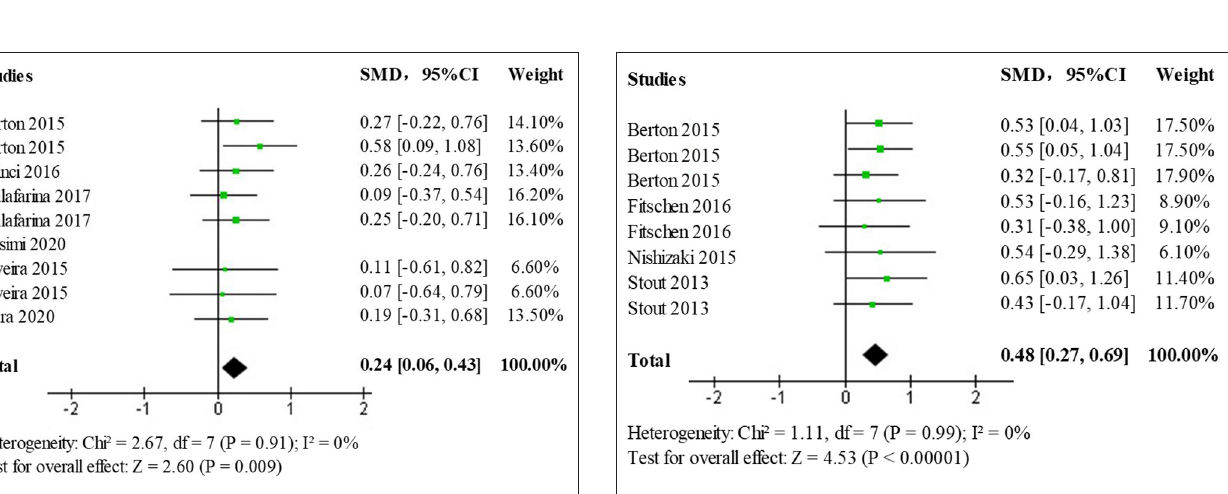
FIGURE 6 | Forest plot of the effect of HMB on upper limb muscle strength after heterogeneous treatment in the elderly population.